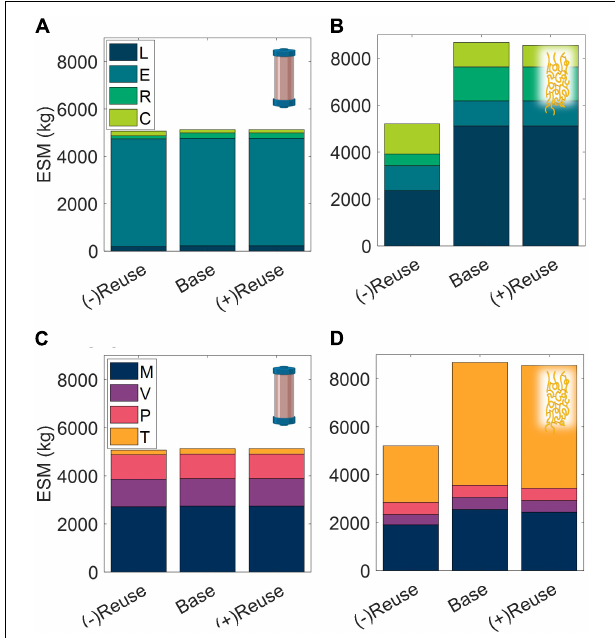
FIGURE 10 | Changes in extended equivalent system mass values with reusability of purification technology broken down by labor (L), equipment (E), raw materials (R), and consumables (C) cost categories and mass (M), volume (V), power (P), and labor time (T) constituents for CHM (A,C) , and ELP (B,D) . (–)Reuse considers the technology as single-use and accordingly discards the unit procedure cleaning operations; (+) Reuse considers additional reuse cycles of the technology. CHM, pre-packed chromatography; ELP, elastin-like